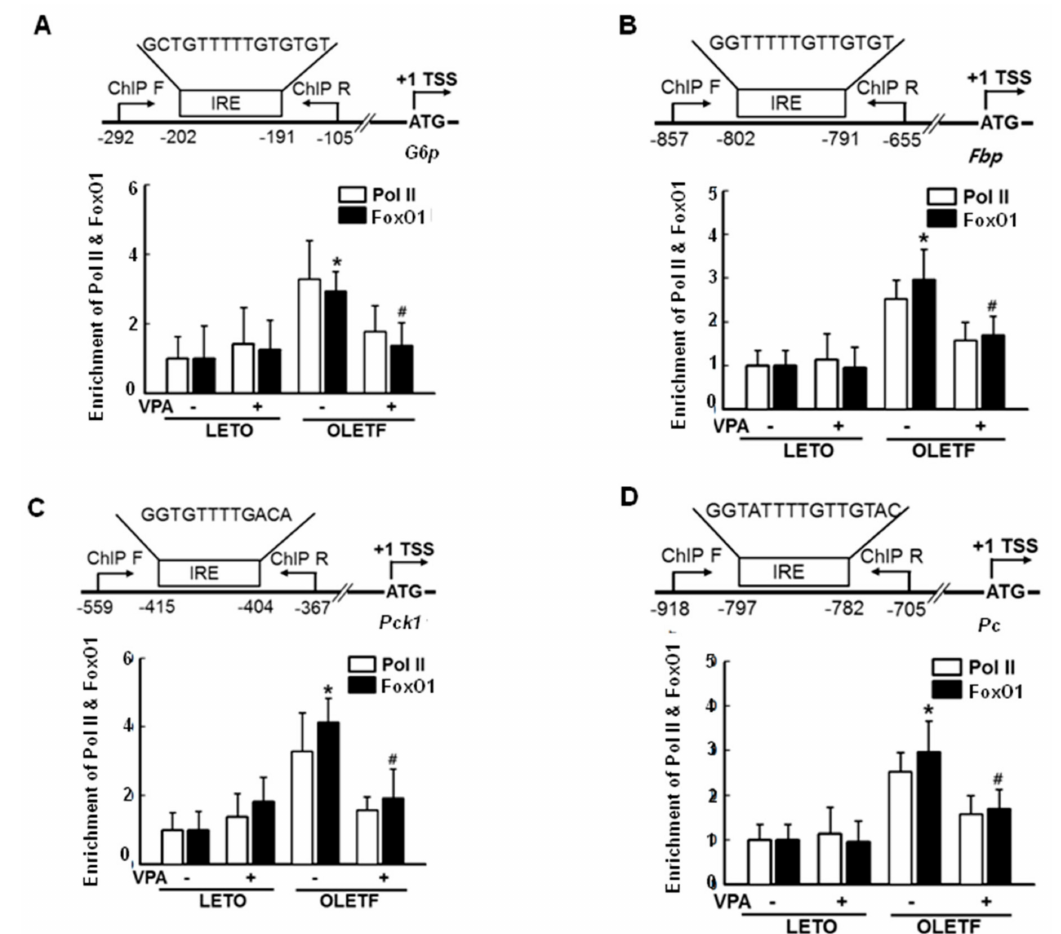
Figure 7. VPA reduces FoxO1 recruitment at target genes in type 2 diabetic rats. Recruitment of FoxO1 and polymerase II to G6p ( A ); Fbp ( B ); Pck1 ( C ); or Pc ( D ) was higher in OLETF rats than that in LETO rats, an effect that was reduced by VPA administration for 20 weeks. The graphs show the mean ± SEM of six independent experiments (* p < 0.05 vs. vehicle LETO; # p < 0.05 vs. vehicle